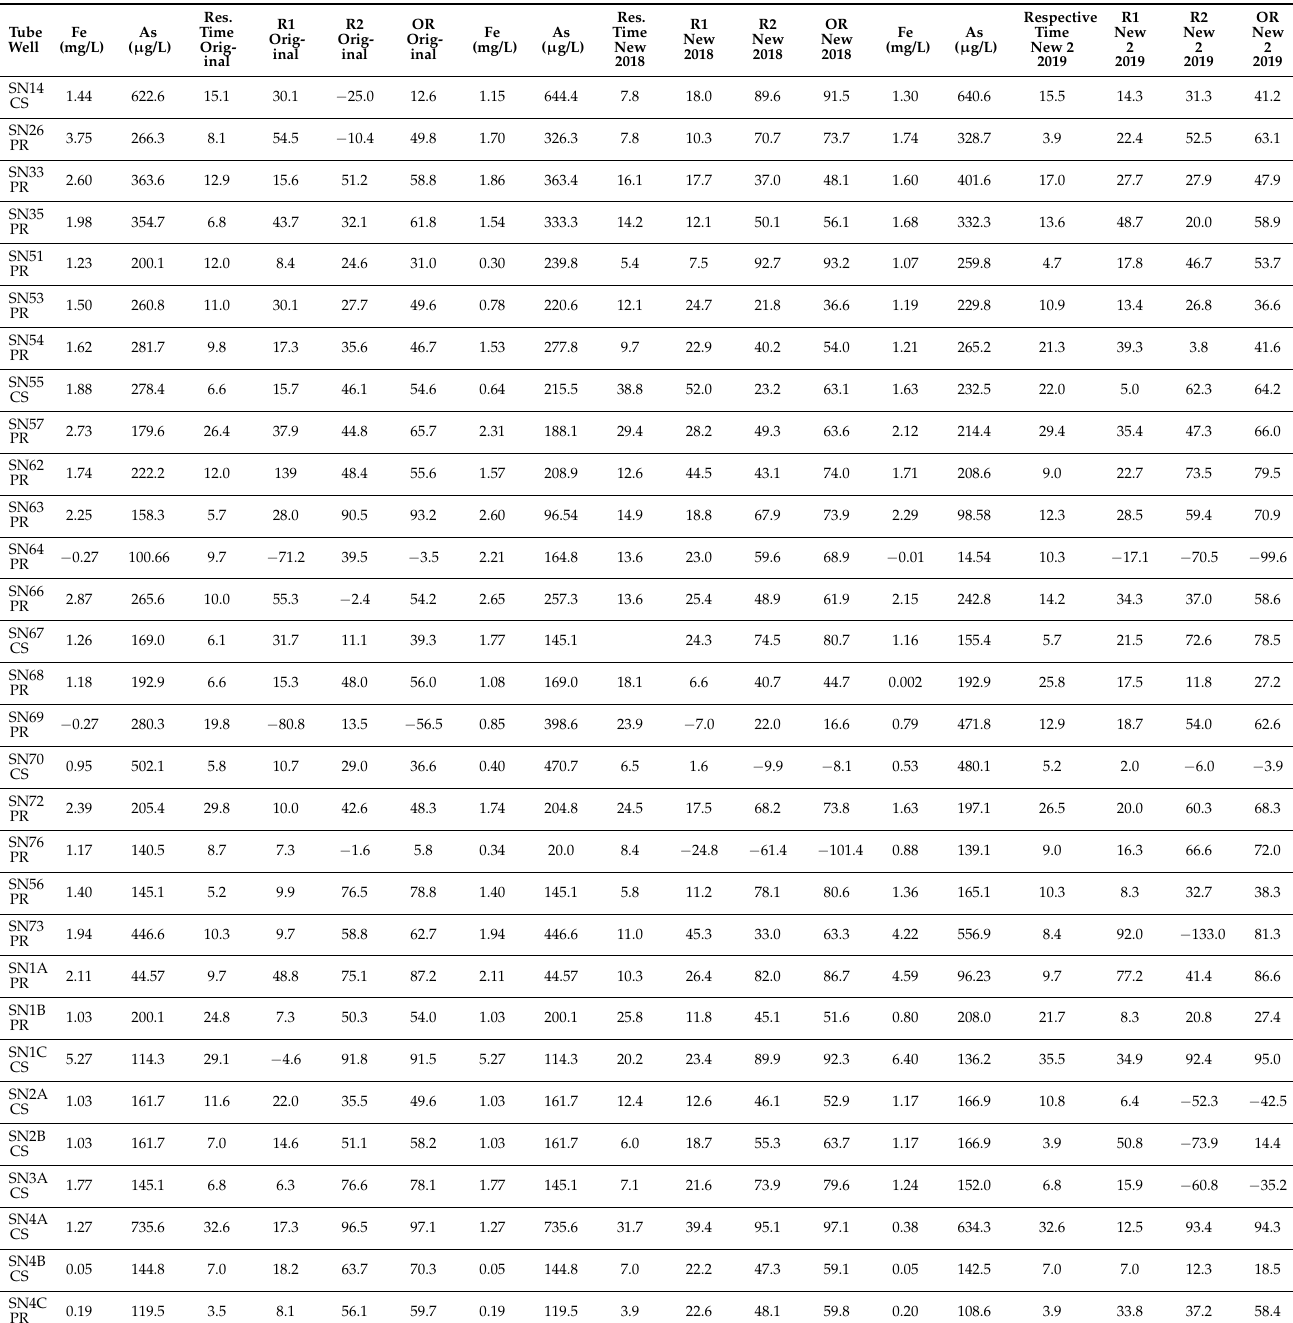
Table 1. Names of tube wells according to ENPHO and the respective removal efficiency in % of the Kanchan filters. Concentrations of Fe (mg/L) and As ( µ g/L) in ground water used to feed the filters. Fe Tube Well